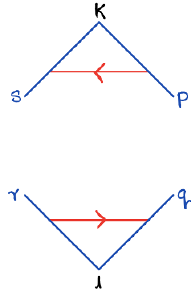
Figure 7 . Arrows and vertices without diagonal ( k; l